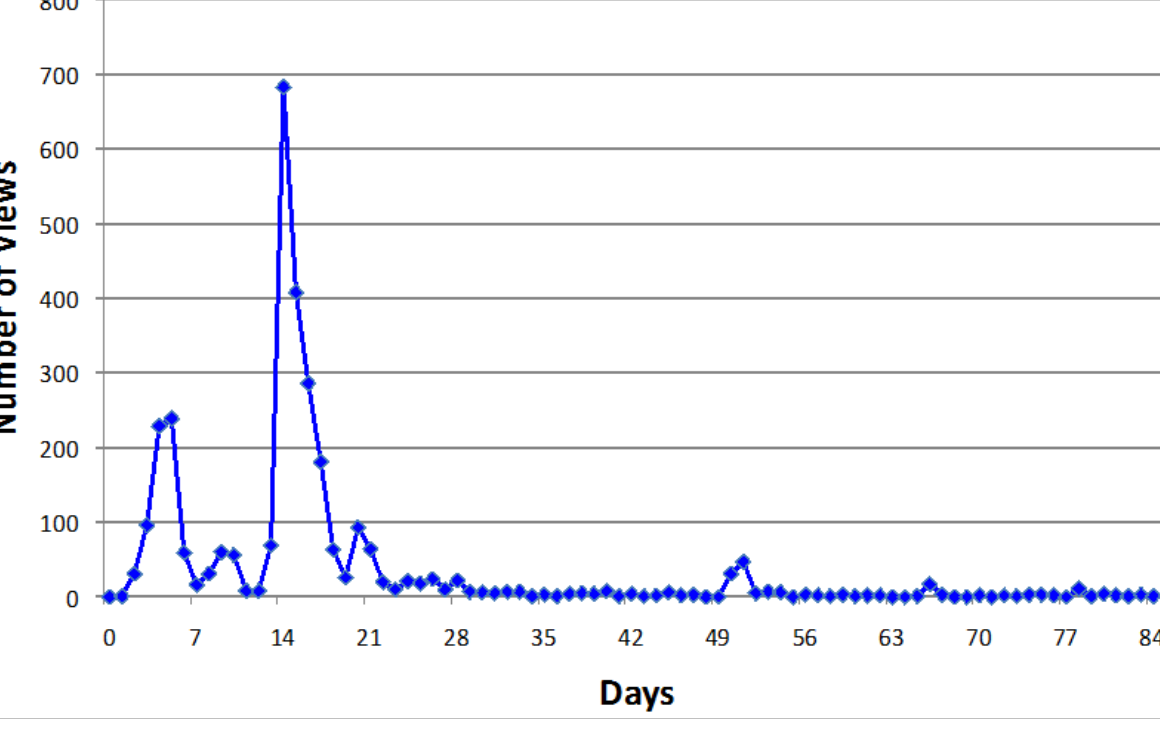
Figure 1. YouTube views over a period of 84 days for the whiteboard animated and voiceover video about superbugs and proper antibiotics use.